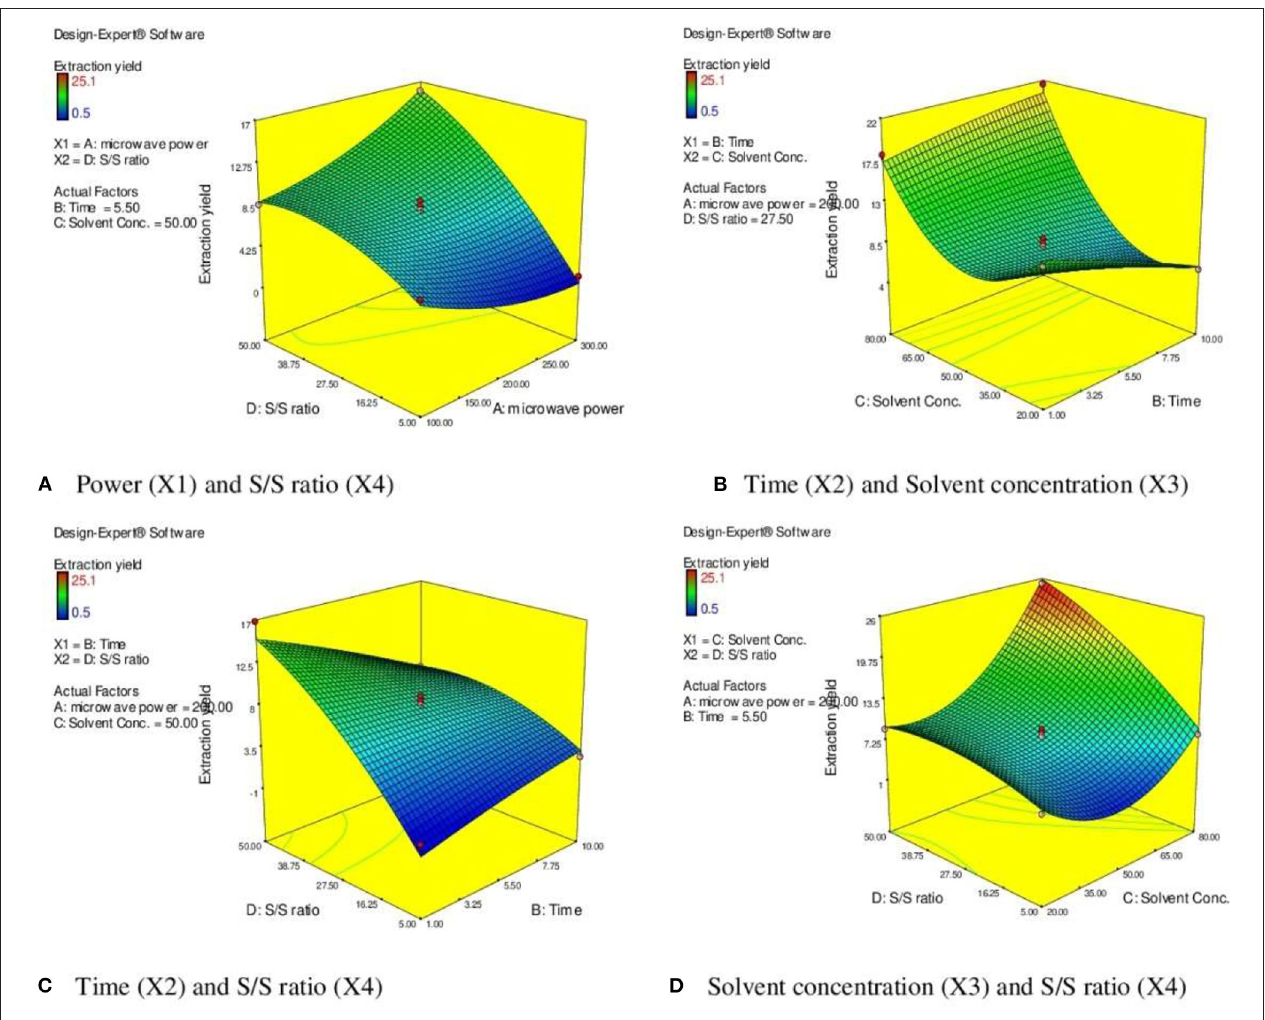
FIGURE 3 | 3 D diagram indicating the effect of different variables (X 1 , X 2 , X 3 , X 4 ) on the response, % EY (Y) in MAE. (A) Power (X1) and S/S ratio (X4). (B) Time (X2) and Solvent concentration (X3). (C) Time (X2) and S/S ratio (X4). (D) Solvent concentration (X3) and S/S ratio (X4). microwave power and increased irradiation time in MAE ( 30, 31, 41,